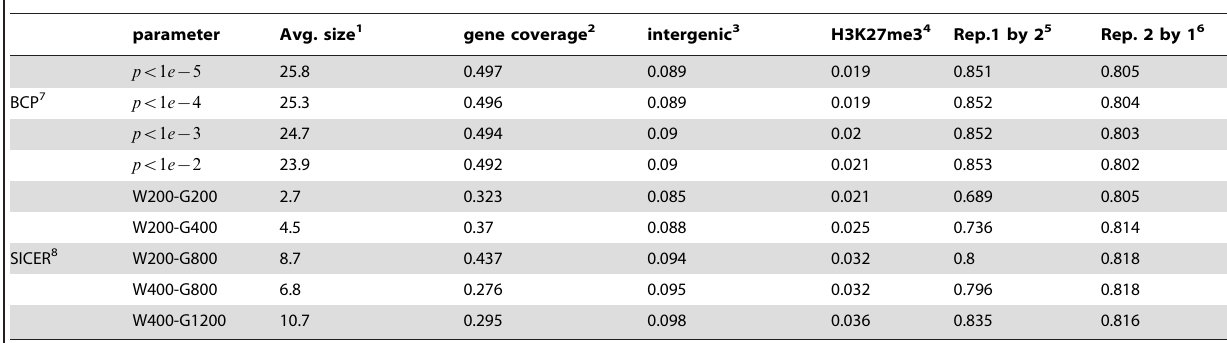
Table 1. H3K36me3 islands and common